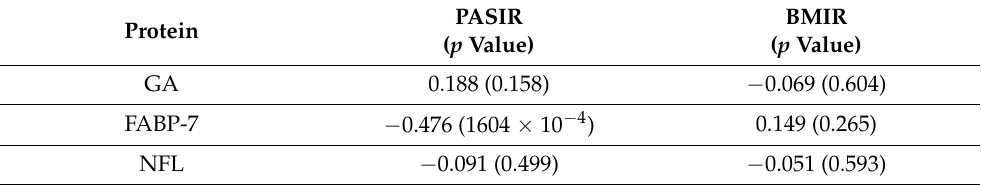
Table 2. Correlations between PASI, BMI and FABP-7, NFL and GA